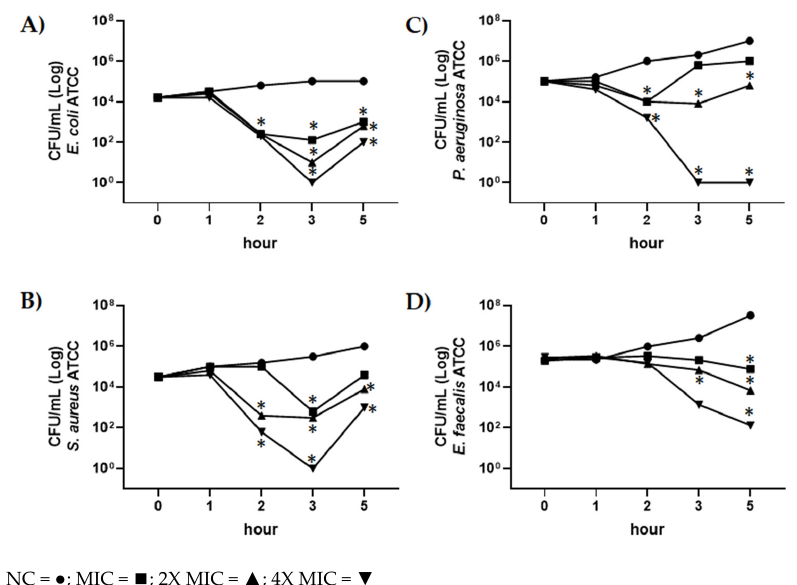
Figure 4. Time-kill kinetics of CBDA against E. coli ATCC 13762, S. aureus ATCC 6538, P. aeruginosa ATCC 27853 and E. faecalis ATCC 29212. Time killing curve of CBDA at MIC ( ◼ ), 2X MIC ( ▲ ), and 4X MIC ( ▼ ) values against ( A ) E. coli ATCC 13762, ( B ) S. aureus ATCC 6538, ( C ) P. aeruginosa ATCC 27853, and ( D ) E. faecalis ATCC 29212. NC (●): negative control. Data were expressed as the mean ± SD of three individual experiments. Calculated statistical significance by Student t test at 1, 2, 3, 5 h vs. 0 h was indicated * p < 0.05.